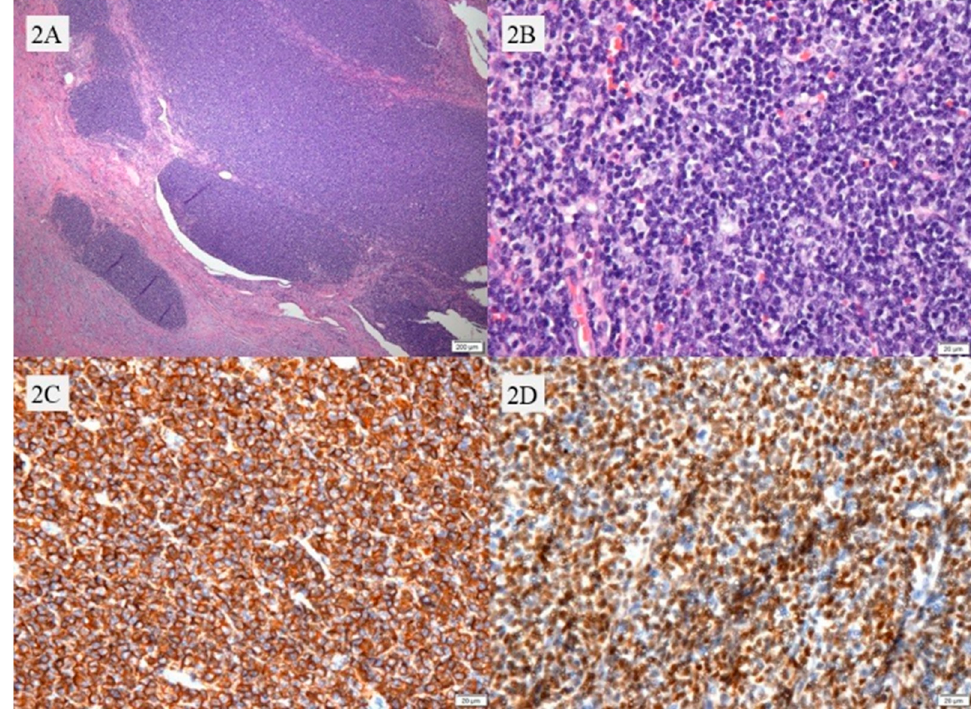
Figure 2. The hematoxylin and eosin (H&E) staining shows mantle cell lymphoma involving the ap- pendiceal lumen with cellular infiltration of whole layers ( A ), original magnification × 4, characterized by small- to medium-sized monotonous atypical lymphoid cells ( B ), original magnification × 40. The neoplastic lymphoid cells showed diffuse positive immunohistochemical staining for CD20 ( C ), origi- nal magnification × 40 and Cyclin D1 ( D ), original magnification × 40.